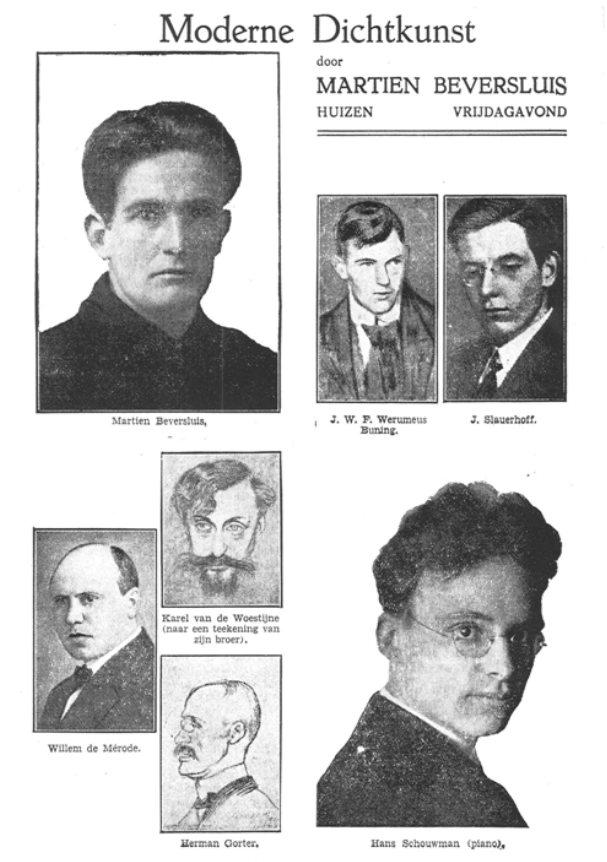
Fig. 3 Advertisement for the VPRO programme ‘Moderne Dichtkunst’, Radio , 2.45 (1928), p.